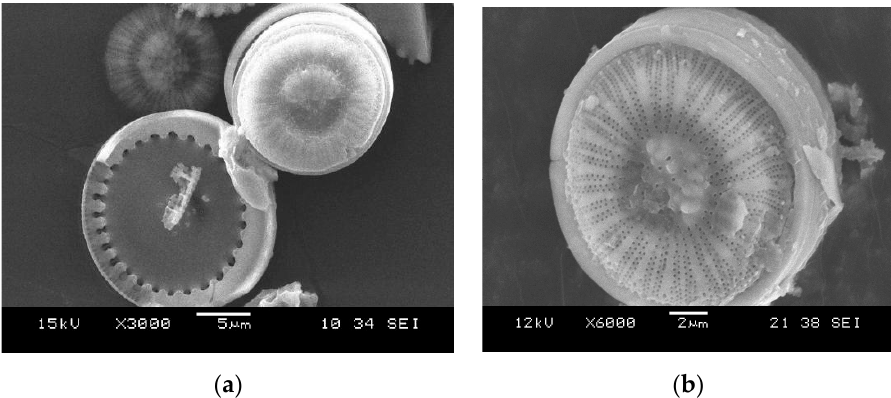
Figure 1. Scanning electron microscope image of diatomite. ( a ) Before activation. ( b ) After activation.